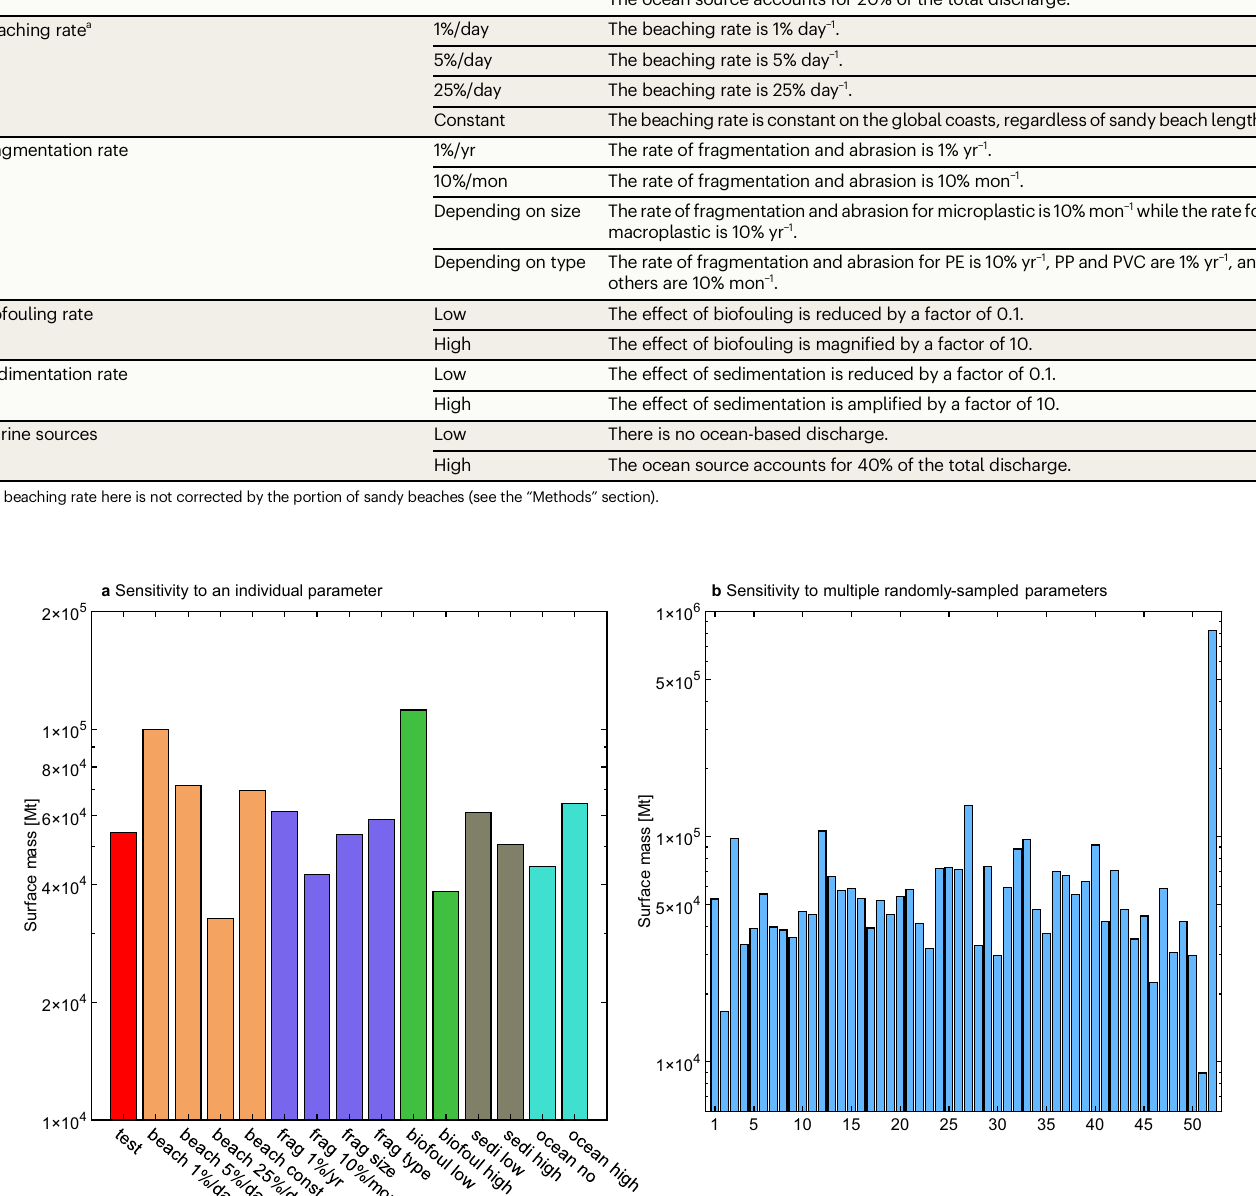
biofouling, and sedimentation rates. Additional members consider uniform beaching rates for all beaches, fragmentation rates depending on particle size and chemical composition, and low and high marine sources (Table